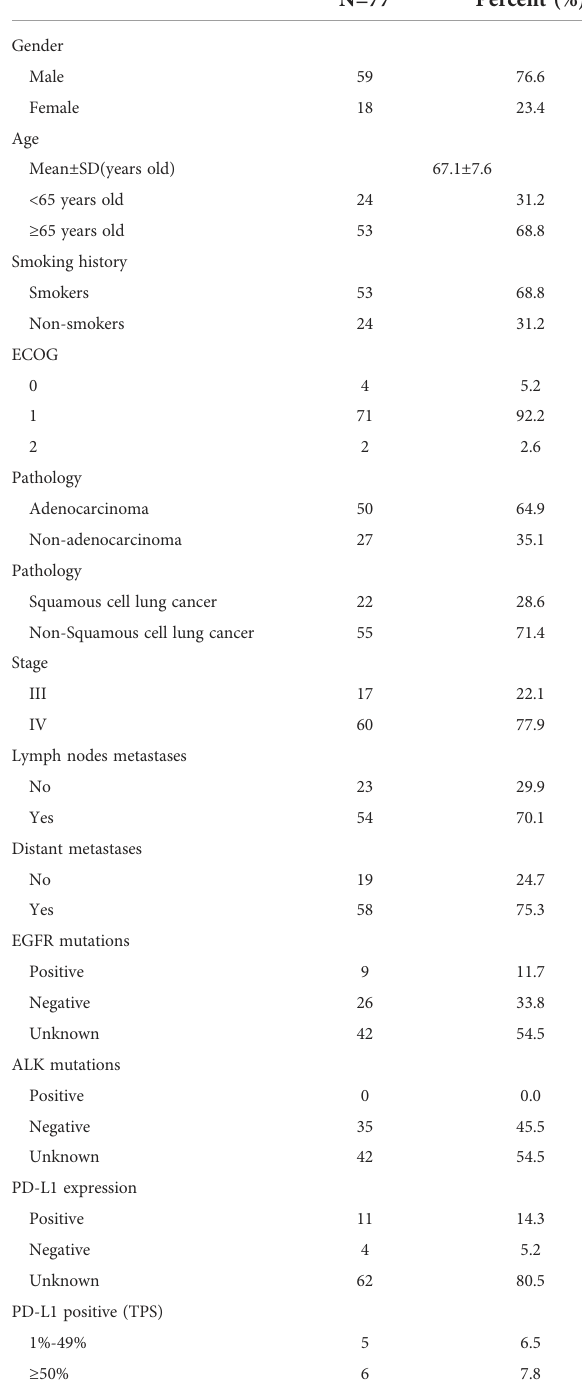
TABLE 1 Baseline characteristics of the enrolled